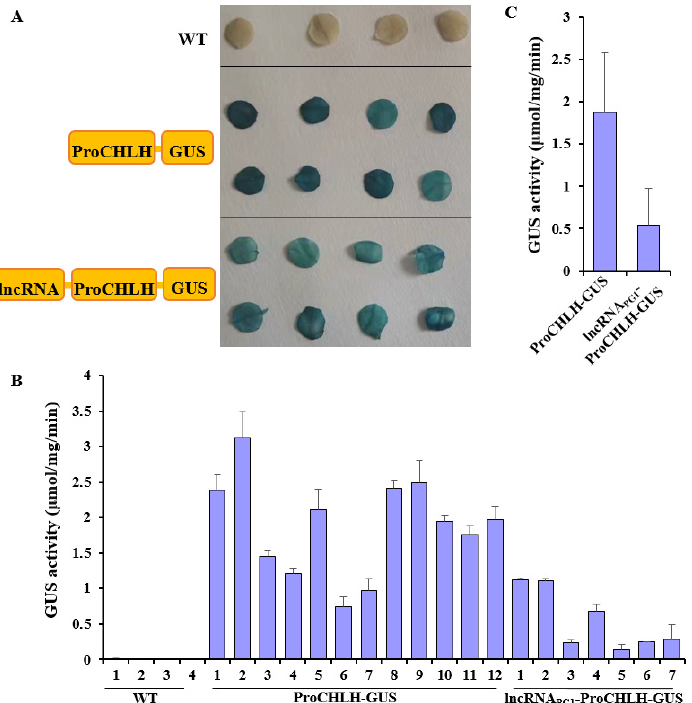
Figure 5. lncRNA PG1 inhibited NtCHLH promoter activity in transgenic tobacco plants. ( A ) Leaf discs images show GUS staining results of four wide-type (WT) plants and eight stable transgenic lines harboring the ProCHLH-GUS or lncRNA PG1 - ProCHLH-GUS construct. ( B ) GUS activities were determined in leaves of four WT plants, 12 ProCHLH-GUS , and seven lncRNA PG1 - ProCHLH-GUS transgenic lines. The results represent means of three technical replicates. Error bars indicate standard deviation. ( C ) Average GUS activity of 12 ProCHLH-GUS lines is compared with the average of seven lncRNA PG1 - ProCHLH-GUS lines.